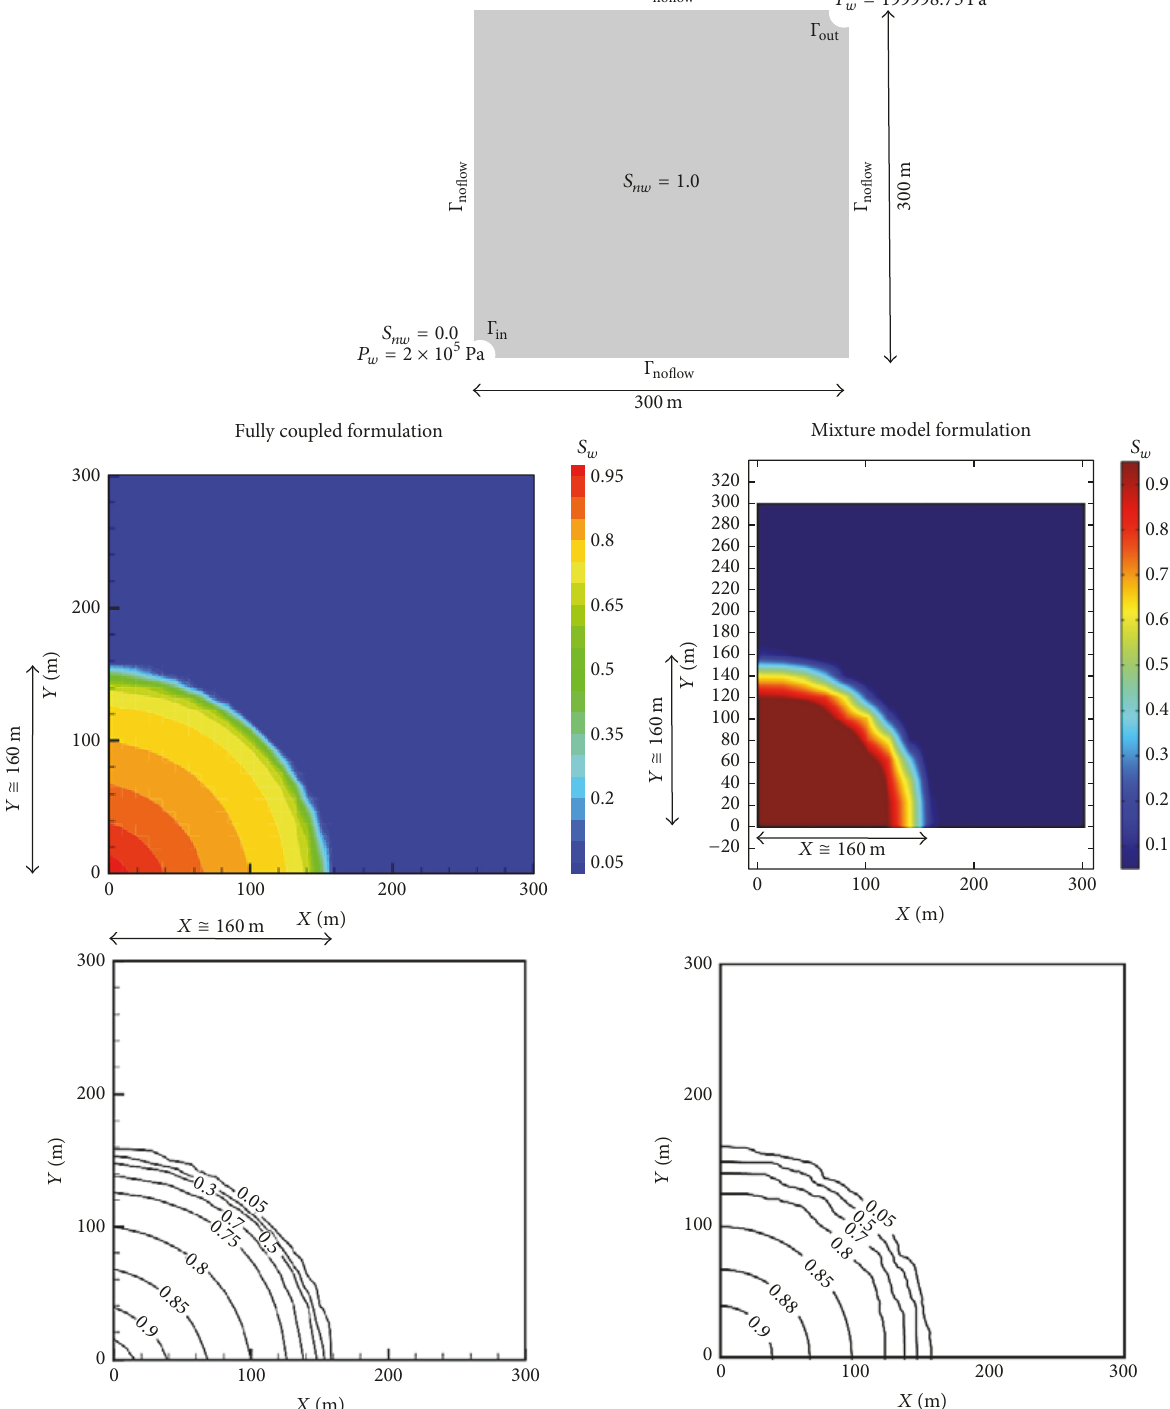
Figure 1: Initial and boundary conditions for the five-spot problem as well as water saturation ( 𝑆 𝑇 = 2000 days and the time step ( Δ𝑡 ) of 1 day for the fully coupled and mixture model formulation with